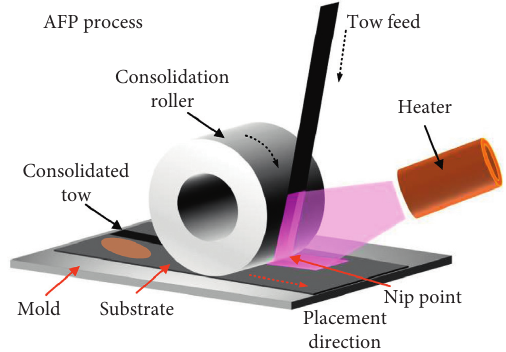
Figure 1: Automated fiber placement (AFP)